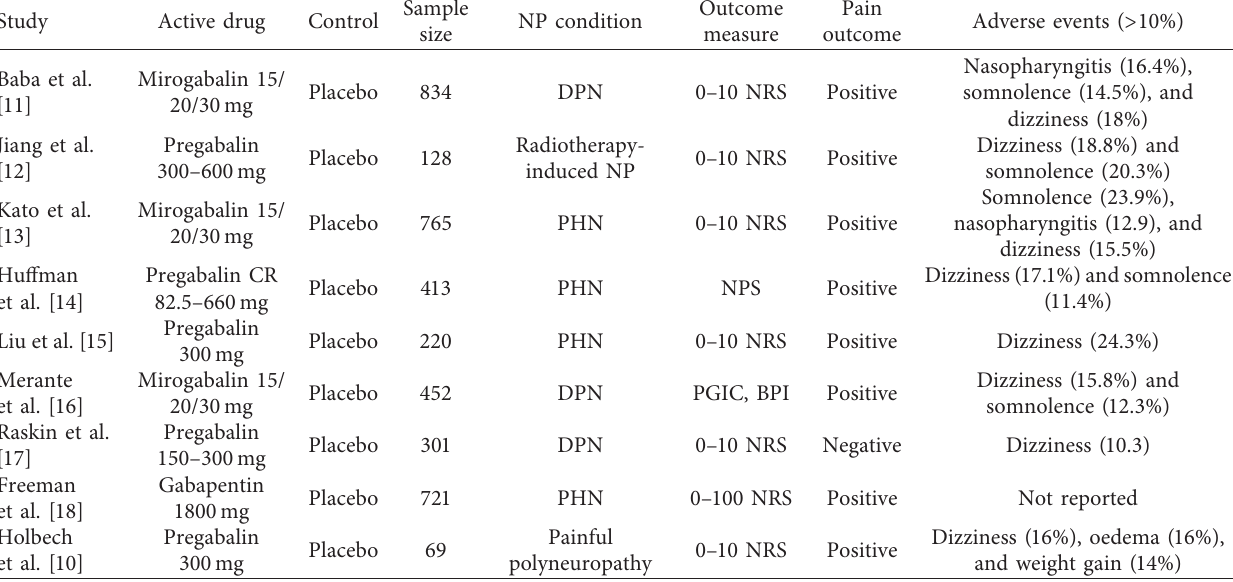
Table 2: Randomized, double-blind, controlled trials testing the effect of gabapentinoids.